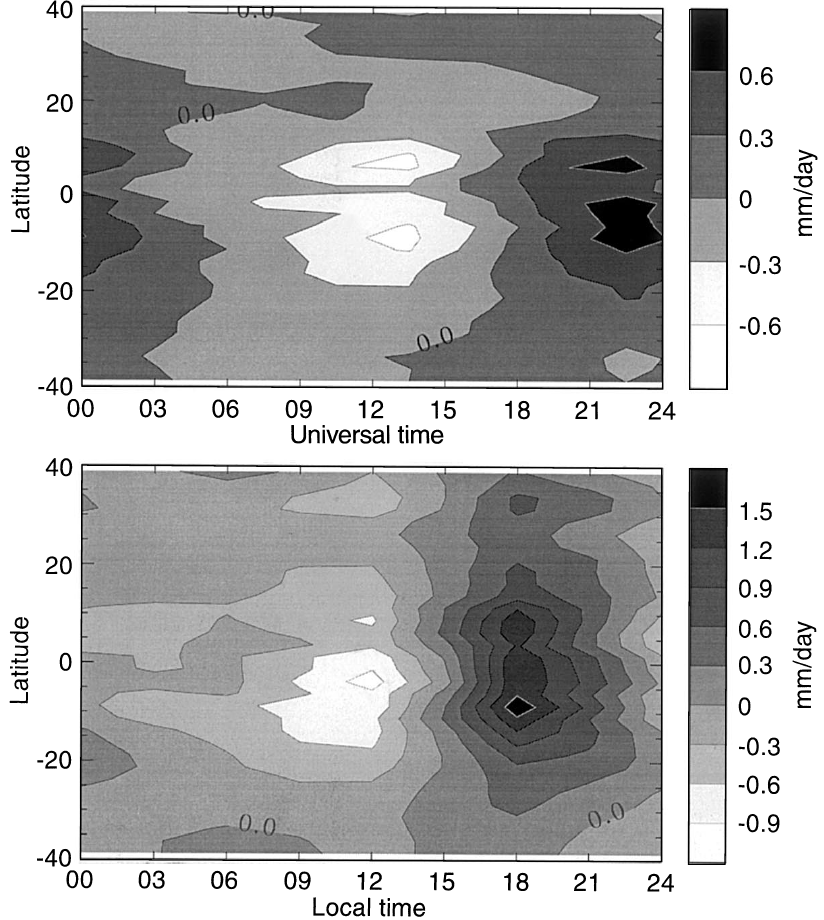
Fig. 3. 7-year (1988–1994) annual-mean dis- tributions of the stationary and solar migrat- ing components of rainfall rate, as derived from satellite-based cloud brightness temper- ature measurements. Top : universal time dis- tribution, i.e., averaged over all local times, consisting of all the stationary wave compo- nents. Bottom : local-time distribution, i.e., averaged over all universal times (or longi- tudes), consisting of all those components which migrate with the apparent motion of